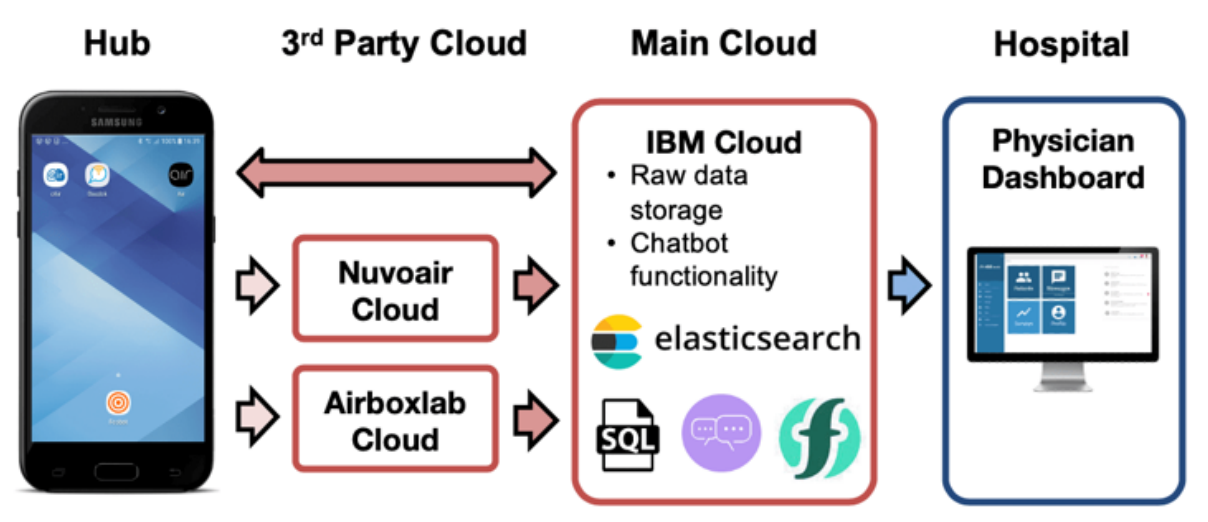
Figure 2. CAir data management architecture and data